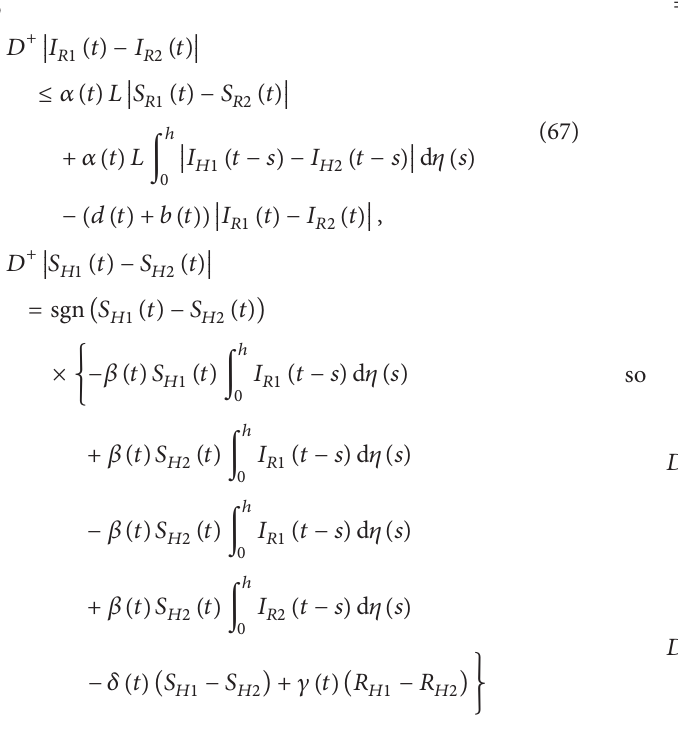
Figure 1: (a)–(e) show that system (3) with initial conditions (𝑆 𝑅 (0),𝐼 𝑅 (0), 𝑆 𝐻 (0),𝐼 𝐻 (0), 𝑅 𝐻 (0)) = (2,0.12, 3,0.15, 0.1) is permanent.